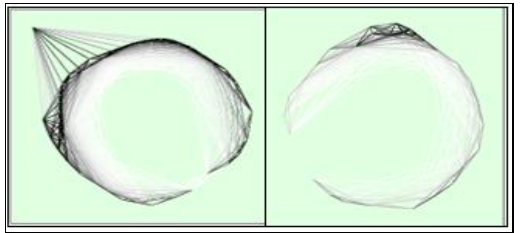
Figure 7. Ellipse of uncertainty canon camera(left), Lenovo camera (right).